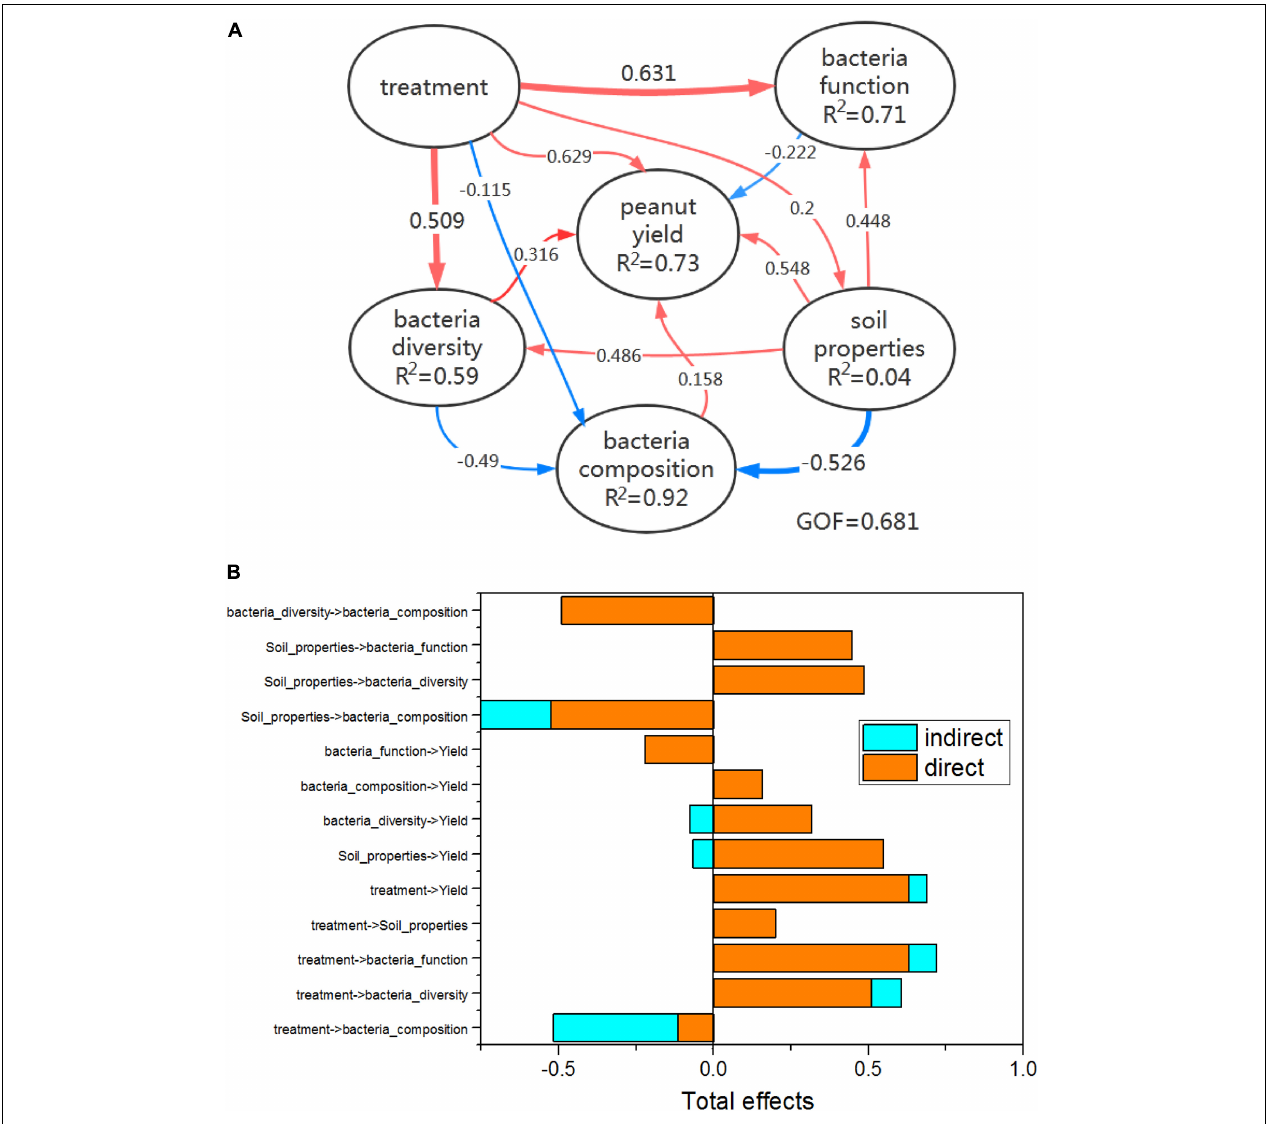
FIGURE 5 | (A) Direct and indirect effects of treatments, soil properties (pH, AP, OM, DTN, and TN), bacteria diversity, bacteria composition, and bacteria functions (abundance of genes involved in P and N metabolism) on peanut yield were shown using PLS-PM. Path coefficients (i.e., direct effects) are written on arrows, and significant coefficients are shown in bold ( p < 0.05). Arrows with positive and negative coefficients are shown in red and blue, respectively. R 2 values represent the variance of dependent variables explained by the inner model. GOF denotes the goodness of fit index. (B) Standardized total effects (i.e., direct plus indirect effects) were calculated using